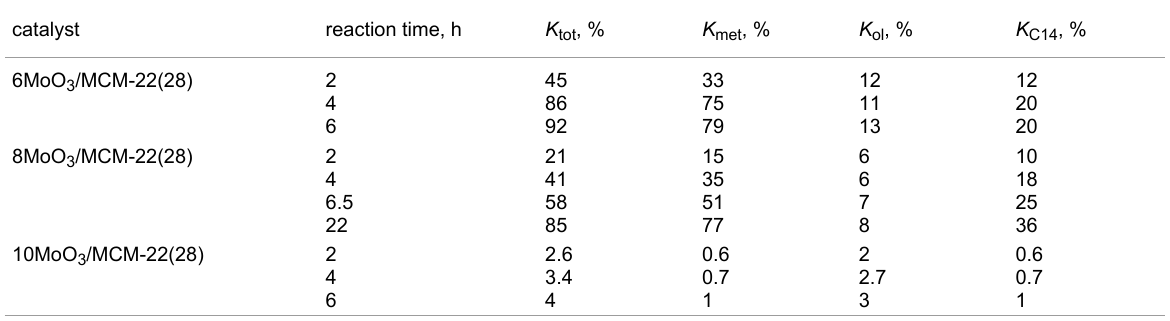
catalyst reaction time, h K tot , % K met , %